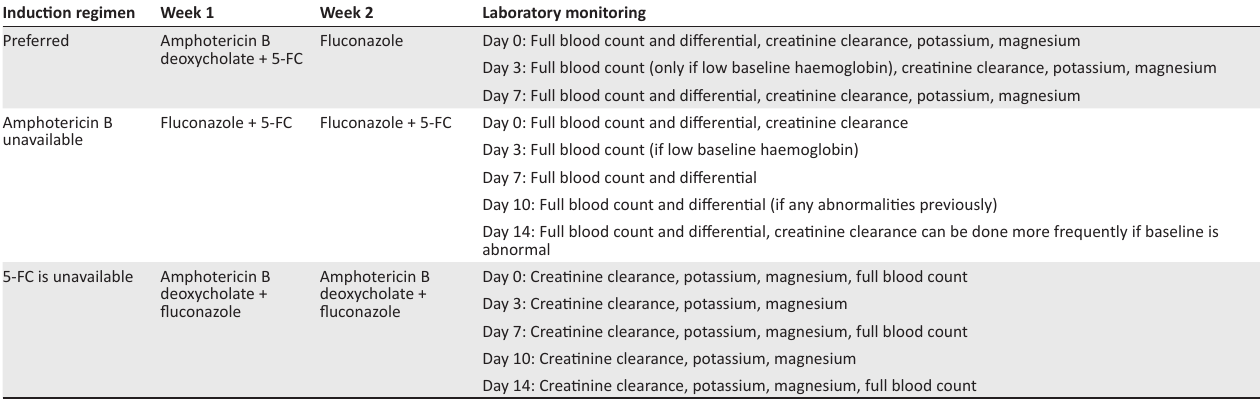
TABLE 8: Laboratory monitoring according to induction regimen used. Induction regimen Week